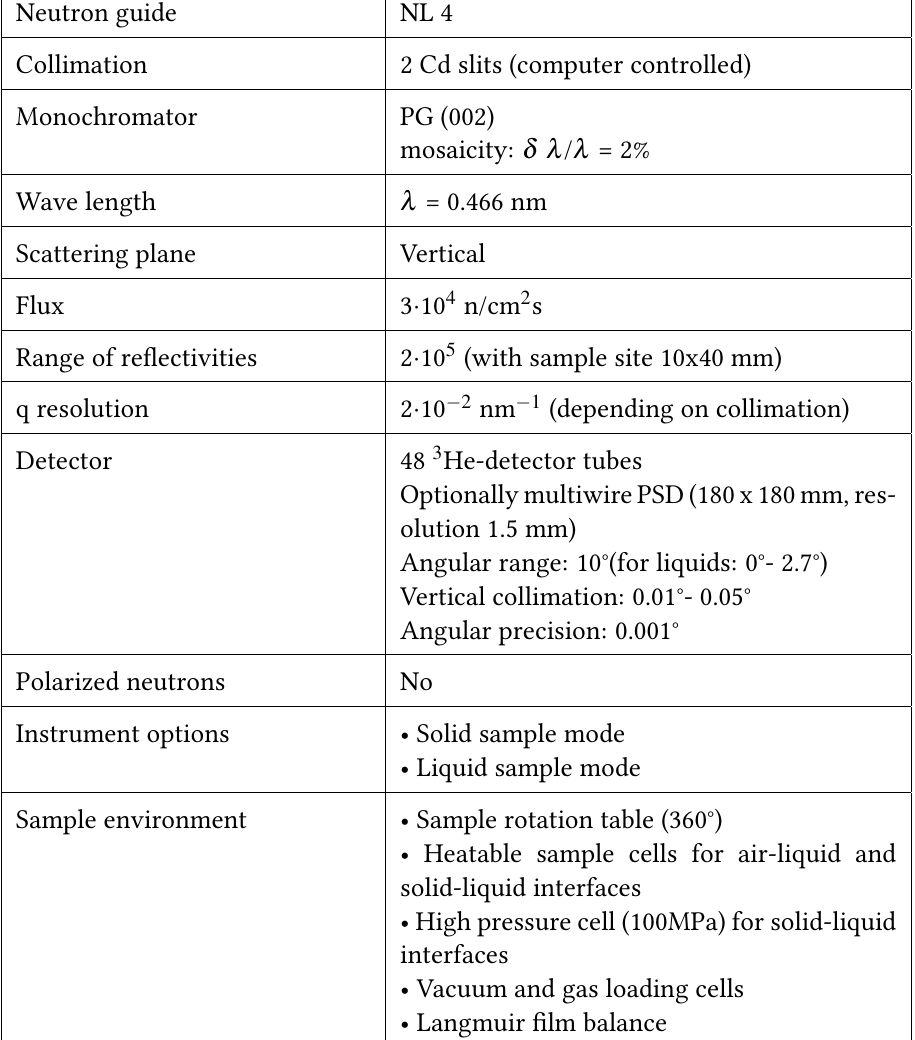
Table 1: Technical parameters of